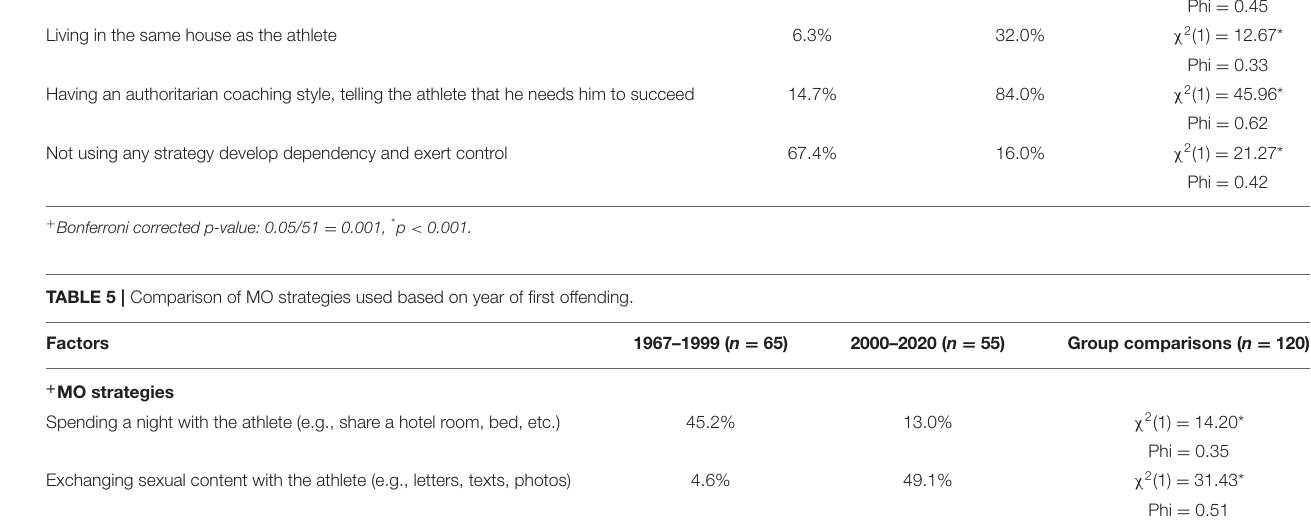
TABLE 4 | Comparison of MO strategies used based on coaches’ sport level. Factors Regional/provincial National/international Group comparisons + MO strategies